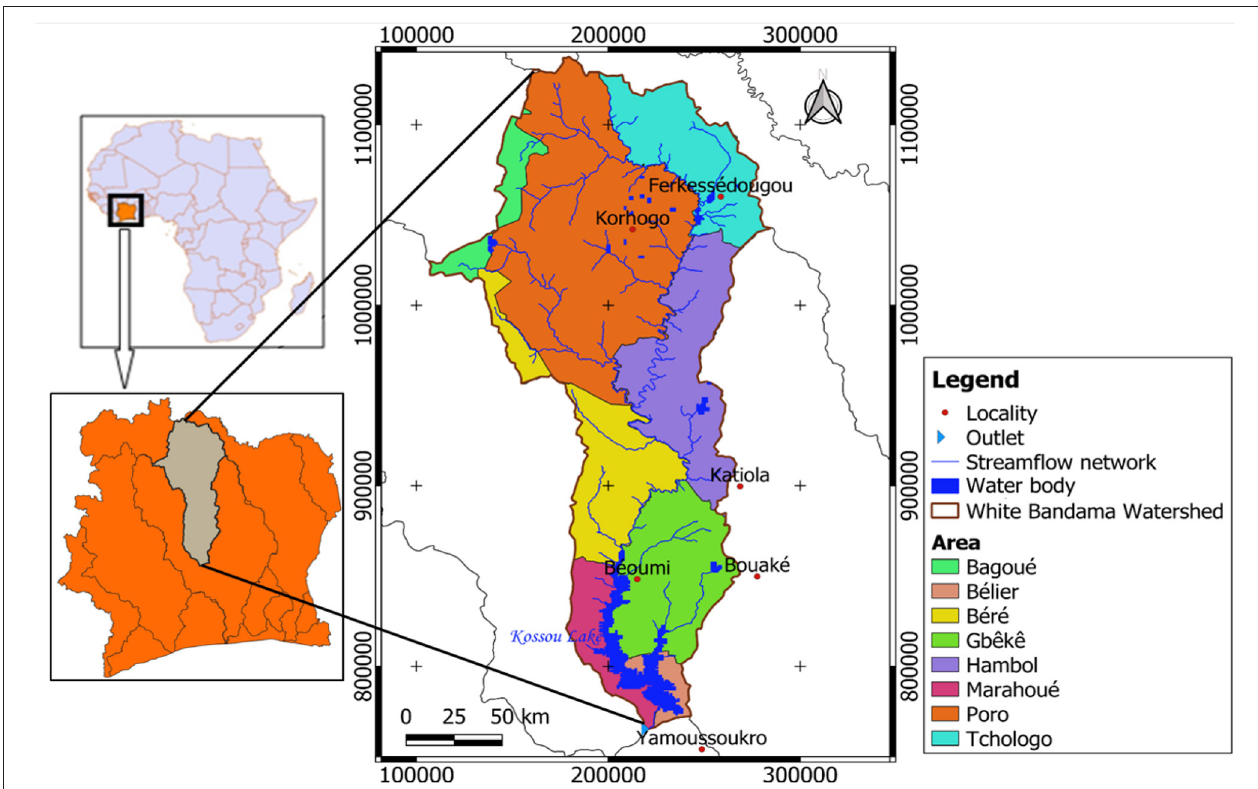
FIGURE 1 | Location of the